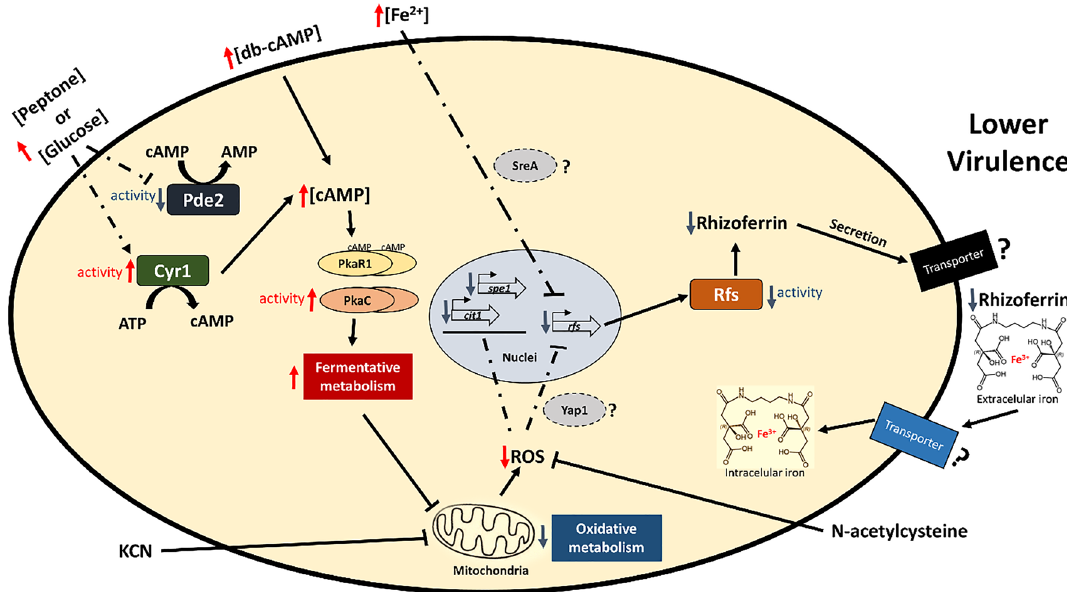
Figure 9. Proposed model for the regulation of rhizoferrin levels via the cAMP-PKA pathway in M. lusitanicus . Presence of organic nitrogen (peptone) or high levels of glucose possibly stimulated the enzymatic activity of adenylyl cyclase (Cyr1) and inhibited phosphodiesterase (Pde2), eventually inducing the generation of high levels of cAMP, which binds to PkaR1 (regulatory subunit 1) of PKA (protein kinase A), thereby activating catalytic PKA (PkaC unknown). This stimulates fermentative metabolism and decreases oxidative metabolism, which negatively regulates reactive oxygen species (ROS) production and decreases the mRNA levels of Rfs, probably via the transcriptional regulation of SreA and Yap1. Lower oxidative metabolism correlates with the downregulation of citrate synthase 1 ( cit1 ) and ornithine decarboxylase ( spe1 ), which synthetize Rfs substrates. This leads to lower levels of rhizoferrin accumulation in the cell exterior, correlating with decreased virulence. In the same context, excess Fe 2+ led to the transcriptional downregulation of rfs , which correlated with lower virulence. Rhizoferrin chelates extracellular iron and transports it to the intracellular space; intracellular rhizoferrin could store iron and help avoid free iron toxicity. Meanwhile, decreased cAMP, low levels of glucose, presence of oxidative stressors, such as H 2 O 2, or stimulation of the activity of Pde2 produced the contrary effect, inducing oxidative metabolism and increasing rhizoferrin production, which correlates with increased virulence of M. lusitanicus